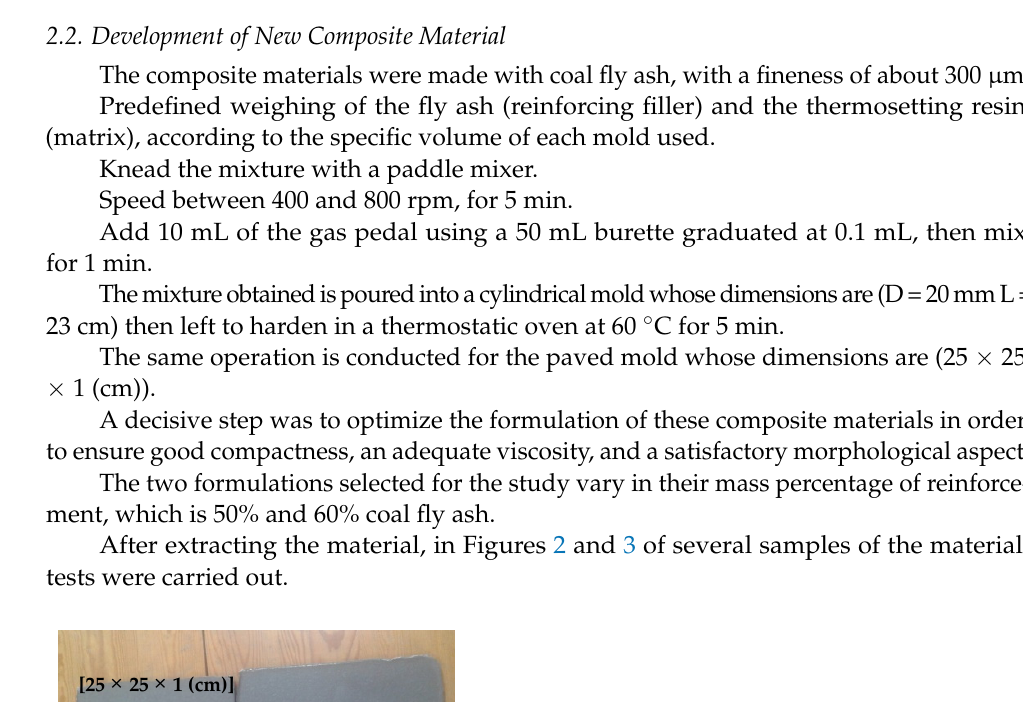
Figure 1. Fly ash (powder) ultra-supercritical power plant SAFIEC.